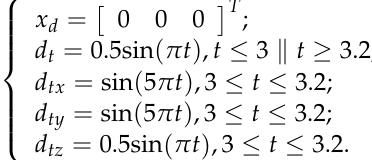
Table 3. The comparison of sine trajectory tracking results of